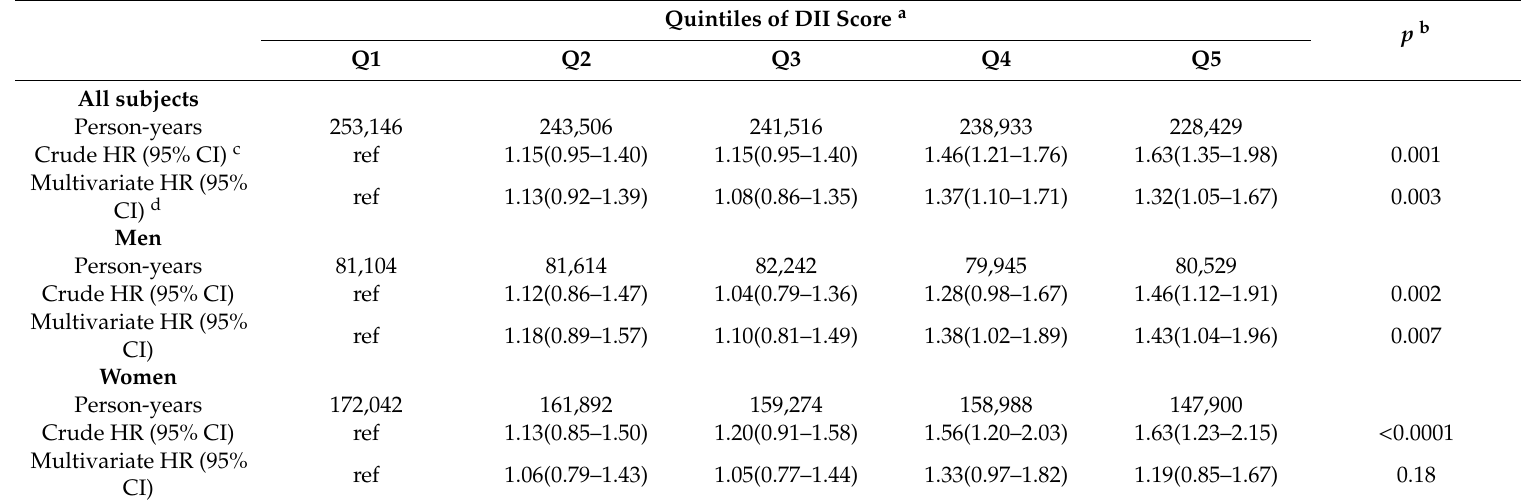
Table 2. Cox proportional hazard ratios (HRs) (95% Confidence Intervals (CIs)) for overall CVD risk by quintiles of the DII score for all participants in the KOGES_HEXA cohort,